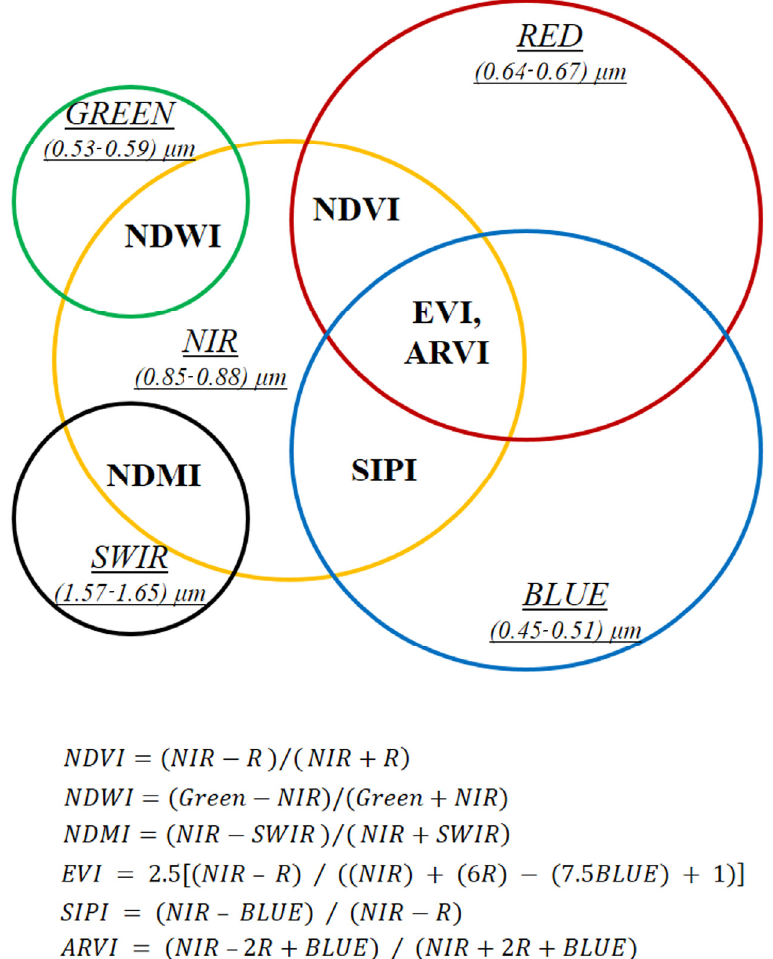
Figure 13. Relationship between the moisture-related indices on how they are calculated using different Landsat 8 image bands (red, green, blue, near infrared, short wave infrared) and their formulas.